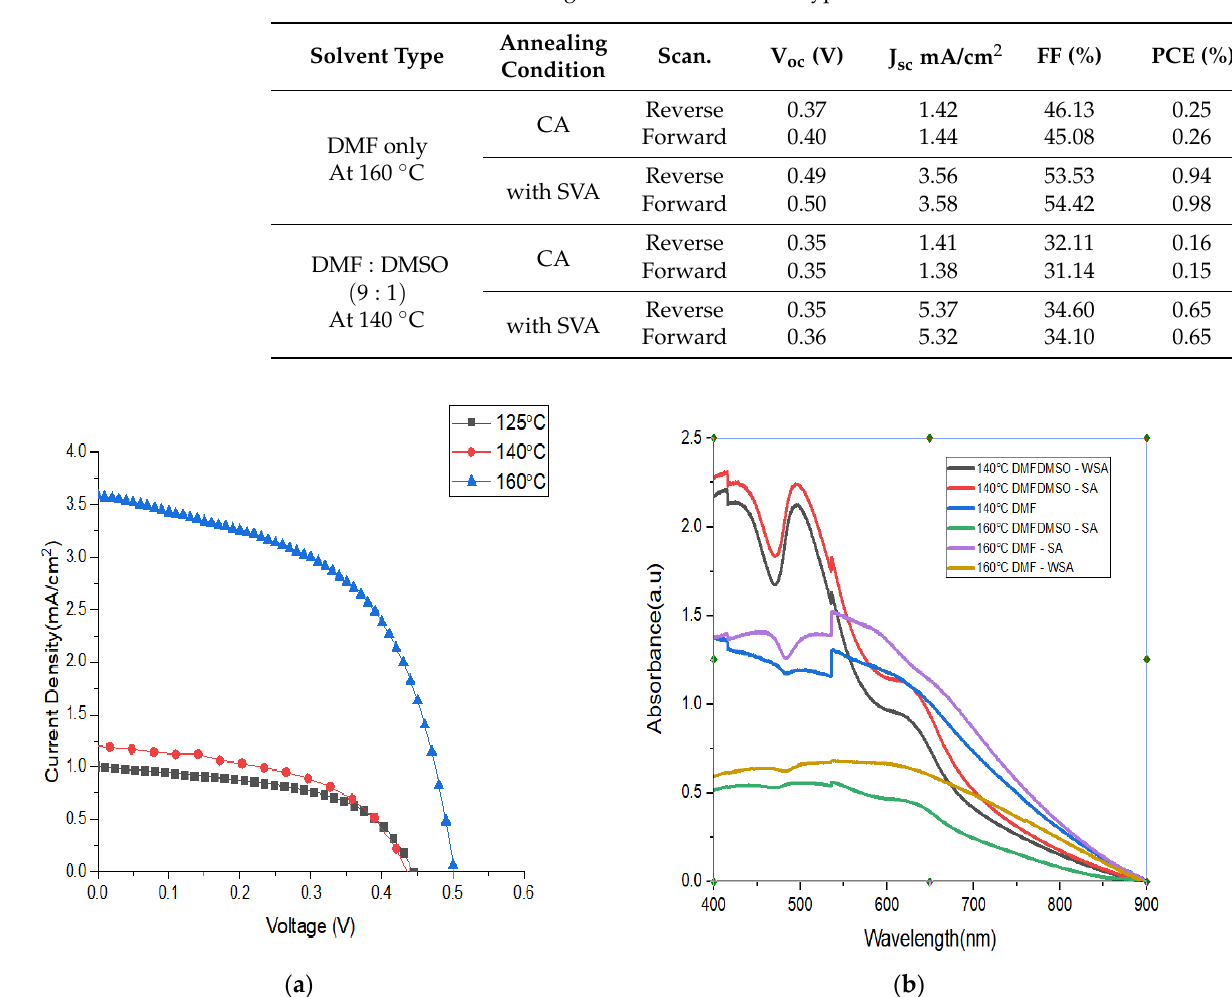
Figure 4. ( a ) I–V characteristics for the cells annealed with and without solvent vapour annealing at 160 °C, while ( b ) shows the effect of annealing temperature on PCE under solvent vapour anneal- ing for the solar cells fabricated under DMF solution. Table 1. Influence of annealing condition and solvent type on I–V characteristics.